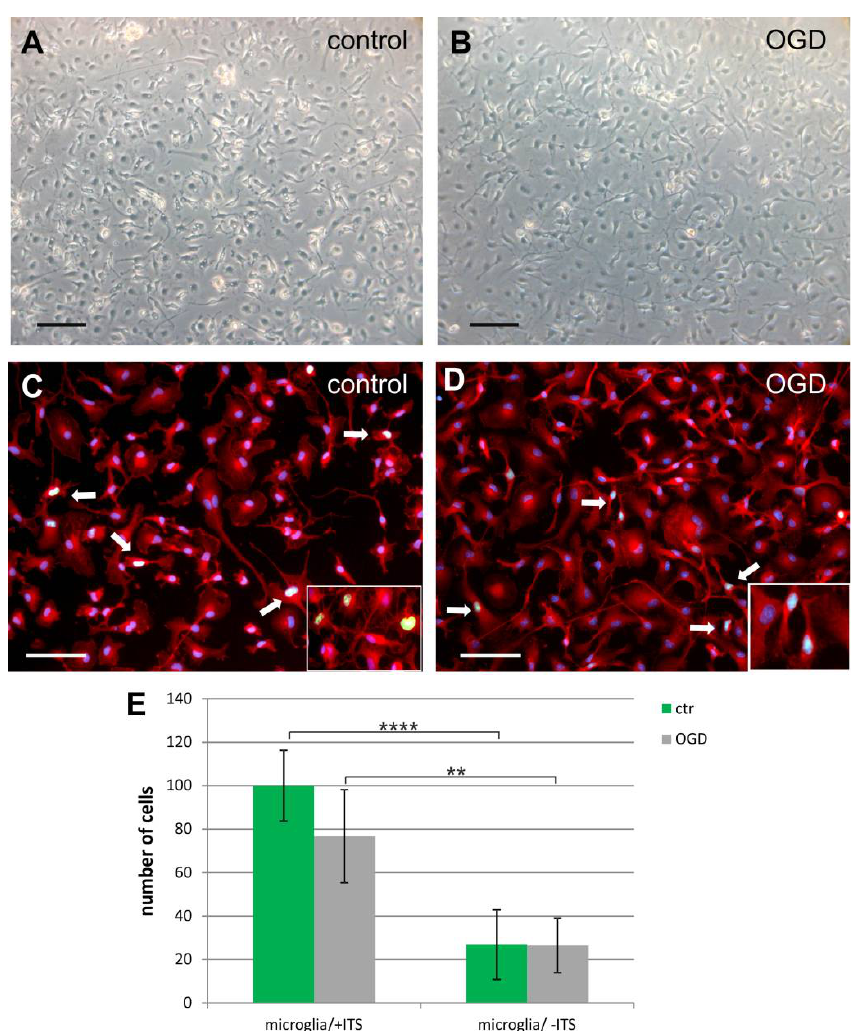
Figure 4. Microglia, the first cell type obtained from the mixed primary culture. ( A ) Live imaging of microglia cultured in serum-free condition in physiological normoxia, 24 h after seeding; ( B ) Live imaging of microglia at 24 h after the OGD procedure; ( C ) During in vitro culturing, the typical morphology of resting microglia is retained, as confirmed by immunostaining with IBA1 marker (red). During the first 2 DIV, cells actively proliferate, as indicated by labelling IBA1 + cells with anti-Ki67 antibody (green). ( D ) Labelling microglia 24 h after OGD procedure shows no significant changes in cell morphology and the rate of proliferation. White arrows indicate proliferating Ki67 + microglia. Cell nuclei are visualized with Hoechst (blue). Scale bar corresponds to 100 μm. ( E ) Graphical presentation of the ITS influence on microglial culture density on 2DIV in controls and after OGD. Serum-free culture medium is conducive for neonatal microglia culturing in physiological normoxia, however ITS addition significantly increases culture density. ** p < 0.01; **** p < 0.0001. Oligodendrocyte progenitors, detached as a middle fraction of glia isolation, proliferated and differentiated in vitro in physiologically normoxic conditions, elongating branched cell processes (Figure 5A,B). The immunofluorescent labeling with a panel of standard, cell-lineage specific markers (NG2, CNP, GalC), specific for the subsequent